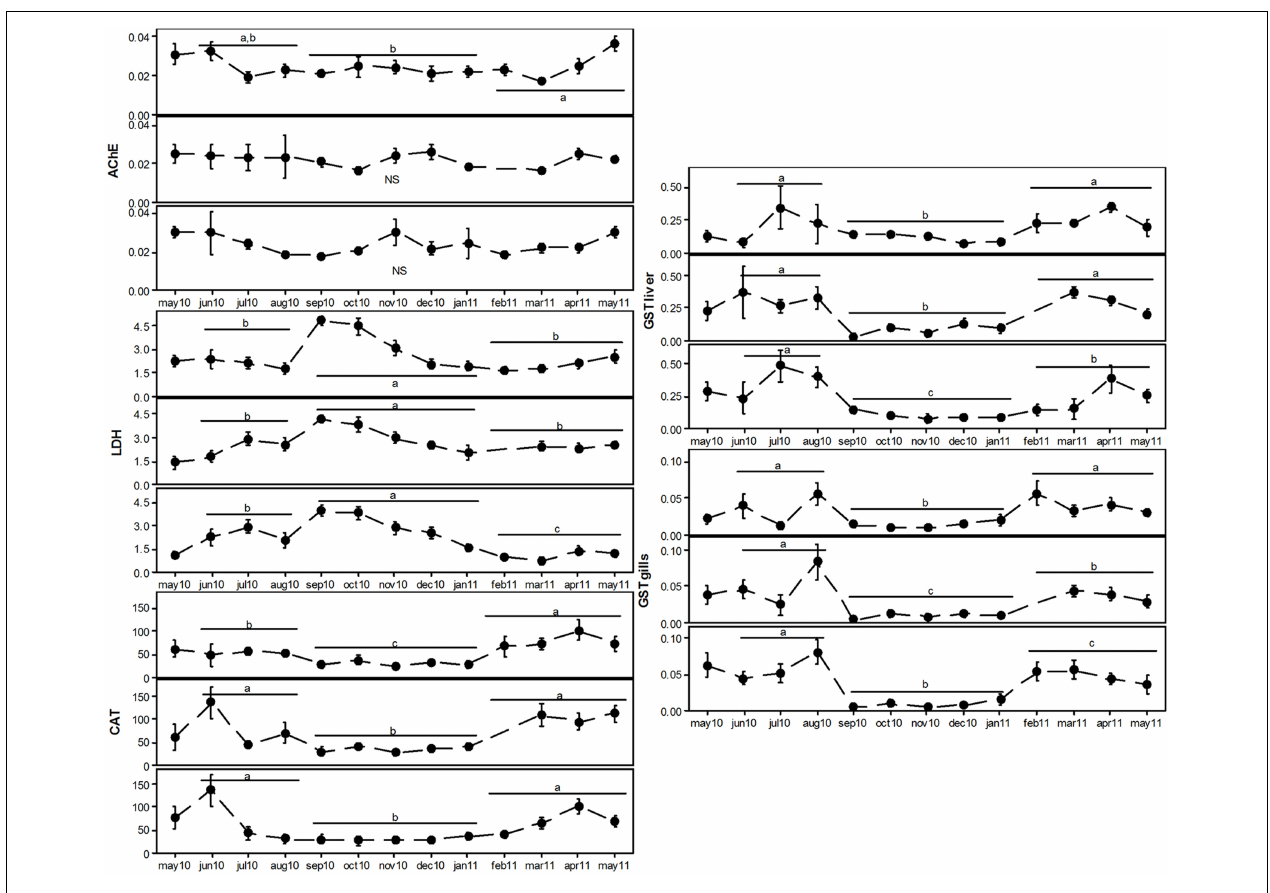
FIGURE 4 | Monthly variation in AChE, LDH, CAT and GSTs of three subpopulations of Sardina pilchardus (Aveiro, top panel; Matosinhos, middle panel; and Peniche, bottom panel). Error bars represent 95% confidence intervals ( n = 10